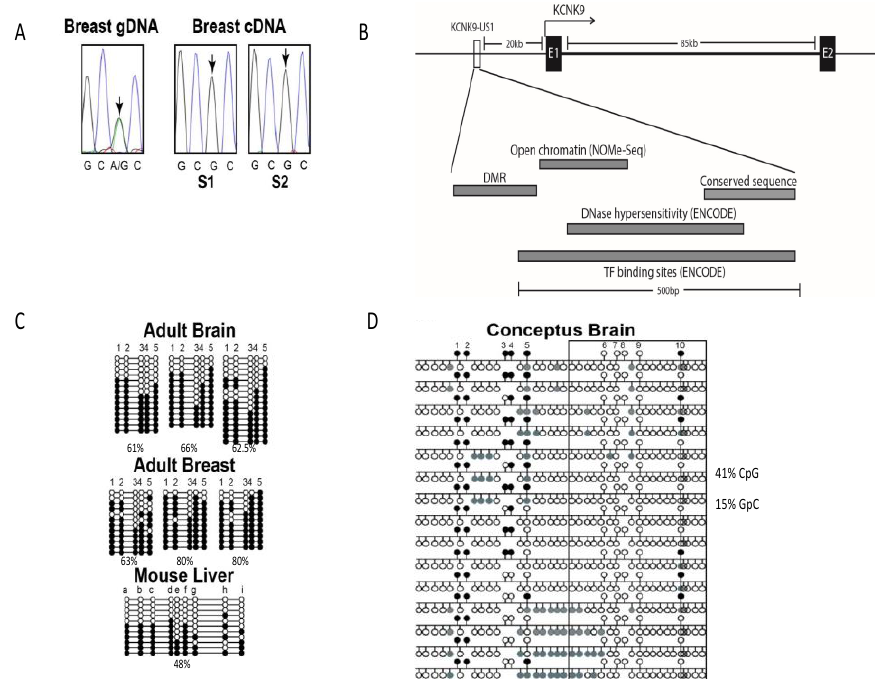
Figure 1. KCNK9 is imprinted in human breast tissue. ( A ) Sequencing of KCNK9 coding single nucleotide polymorphism (SNP) rs2615374 from breast tissue. Individuals S1 and S2 were het- erozygous for this SNP (A/G), but only one allele (G) was expressed. The position of rs2615374 used to determine allelic expression is indicated by the arrows. ( B ) Exon 1 (E1), exon 2 (E2). Bars indicate the regions of differential methylation (DMR), open chromatin (NOMe-Seq) determined in this study, regions of cross species conserved sequence (human GRCh37/hg19 compared to mouse GRCm38/mm 10), DNase hypersensitivity (ENCODE), and transcription factor binding (ENCODE). Transcription factors binding in this region include NRSF, GATA3, and AP-2. ( C ) Sequencing of cloned methyl-PCR products from the upstream DMR ( KCNK9 -US1 DMR) in adult human brain and breast, and the orthologous KCNK9 upstream sequence in mouse liver, open circle, unmethy- lated cytosine; black filled circle, methylated cytosine in the differentially methylated region (DMR). ( D ) NOMe-Seq of cloned methyl-PCR products from KCNK9 -US1 DMR in conceptus brain, showing an inverse relation between CpG methylation and open chromatin structure. Upper circles—CpG sites (in vivo methylation: open circle, unmethylated cytosine; black filled circle, methylated cyto- sine). Lower circles—GpC sites (in vitro methylation, chromatin structure dependent: open circle, unmethylated cytosine, closed chromatin; gray filled circle, methylated cytosine, open chromatin). Boxed region—area of transcription factor binding from ENCODE data (Figure